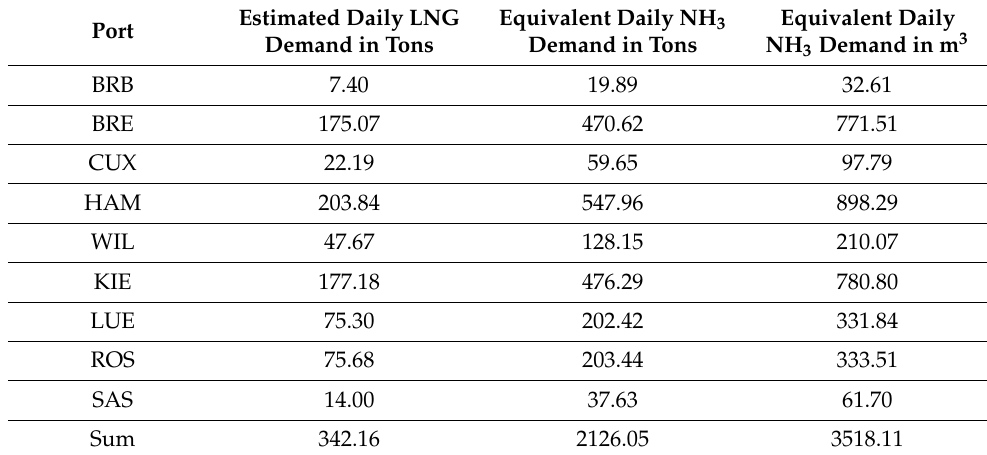
Table 2. LNG and NH 3 demand estimation for German ports (authors’